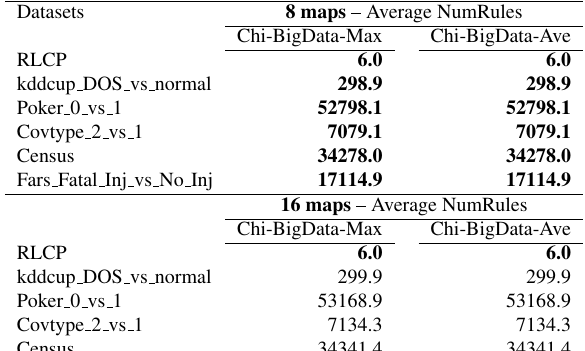
Table 8. Example of number of rules generated by map and number of final rules for the Chi-FRBCS-BigData-Max version with 8 maps Kddcup DOS vs normal dataset NumRules by map Final numRules RB 1 size: 211